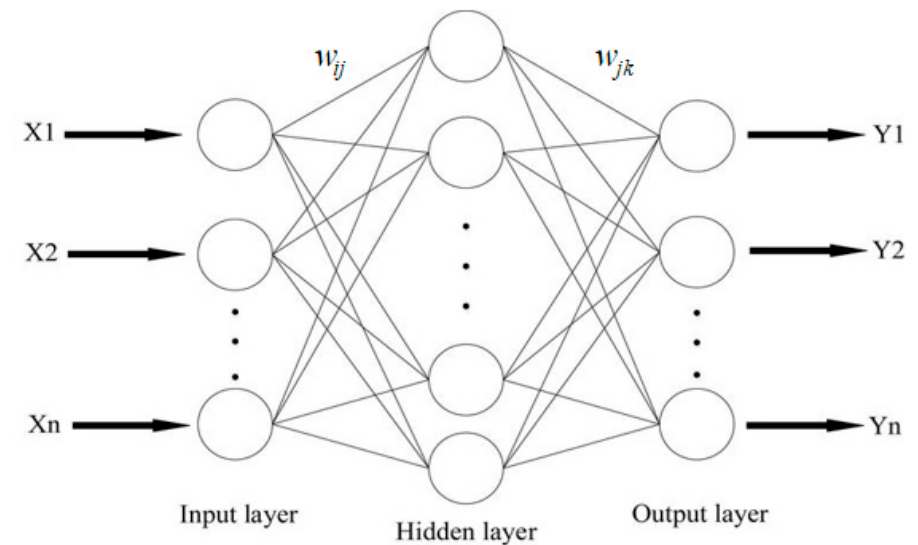
Figure 2. Illustration of a three-layer back propagation neural network.